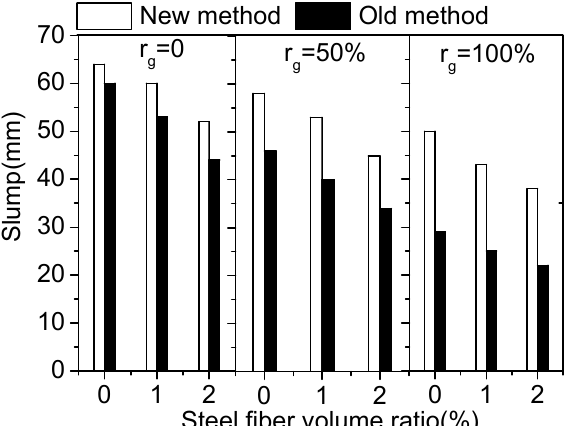
Figure 5. Comparison of slump by using different sand ratio method.